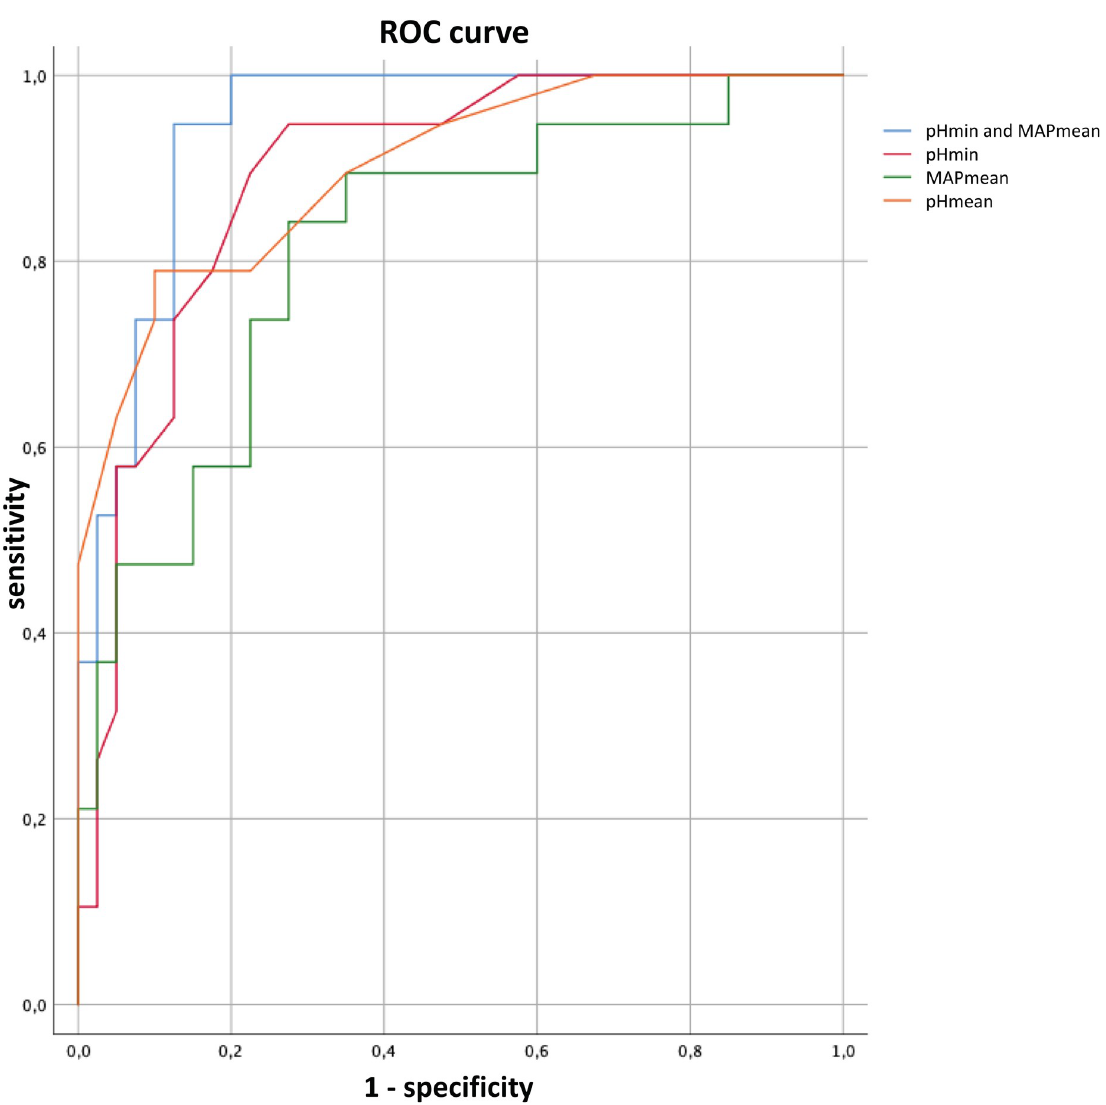
Fig 4. Comparison of receiver operating characteristics (ROC) curves. The calculated model with pHmin and MAPmean allows the best prognosis of outcome (area under the curve (AUC) = 0.945). Models with pHmin, MAPmean, and pHmean alone led to values of 0.893, 0.816, and 0.901. For better comparison, pHmin, MAPmean, and pHmean were multiplied by a factor of -1 when generating the ROC curve. MAPmean, mean MAP during the 14-day observation period for each patient; pHmean/pHmin, mean/minimum blood pH during the 14-day observation period for each